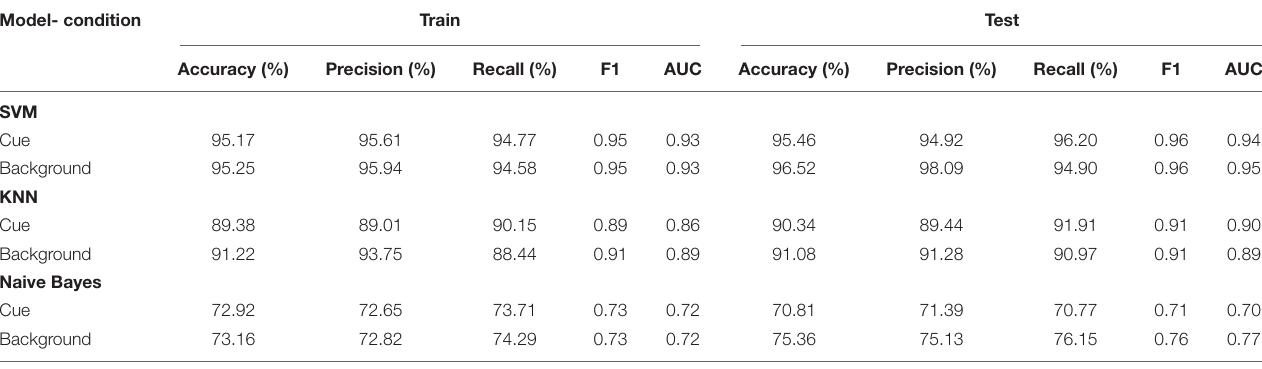
TABLE 2 | Results of classifying FR and noFR based on six frequency bands. Model- condition